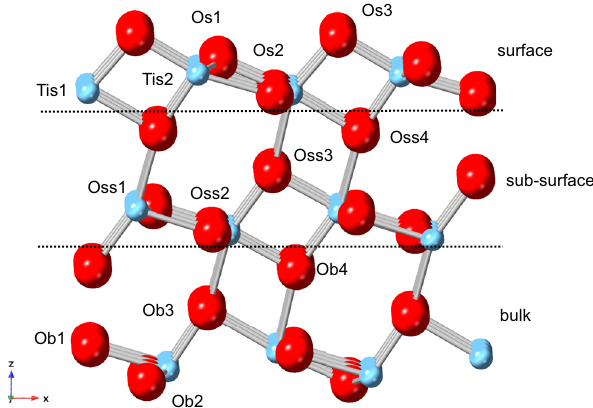
Fig. 5 The model of titanium oxide nanoparticle showing different oxygen species on surface, subsurface and bulk. Pristine anatase (101) supercell showing assigned depth environments and inequivalent (relative to surface, not vacancy) oxygen (red) and titanium (blue) sites in each. Depth: s (surface); ss (sub-surface); b (bulk). Volume of vacuum not shown. Note, there is no O s4 due to surface termination.